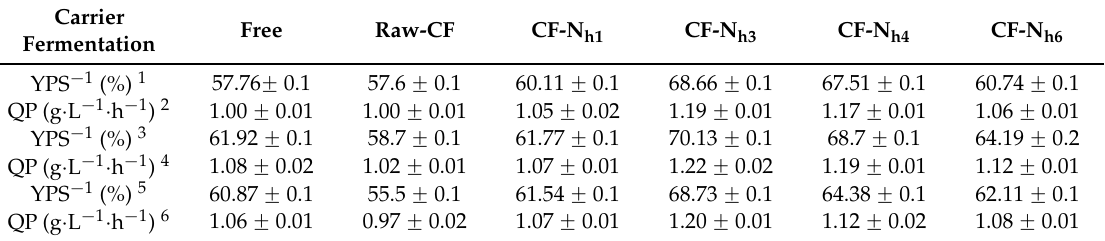
Table 3. Yield and volumetric productivity in the multi-batch fermentation of xylitol.